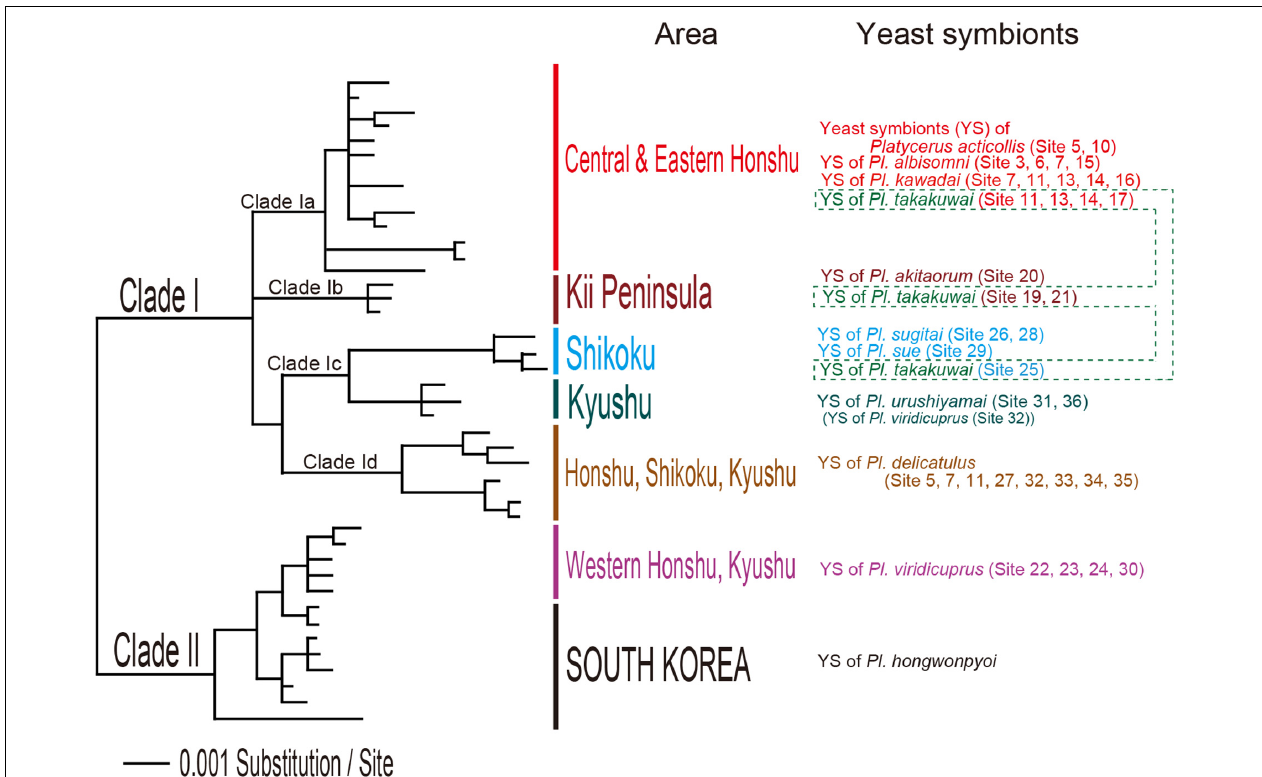
FIGURE 2 | Bayesian inference (BI) phylogeny of yeast symbionts of Platycerus species in Japan based on intergenic spacer (IGS) sequences. The IGS sequences of South Korean Platycerus hongwonpyoi yeast symbionts were added as the outgroup (modified from Kubota et al.,